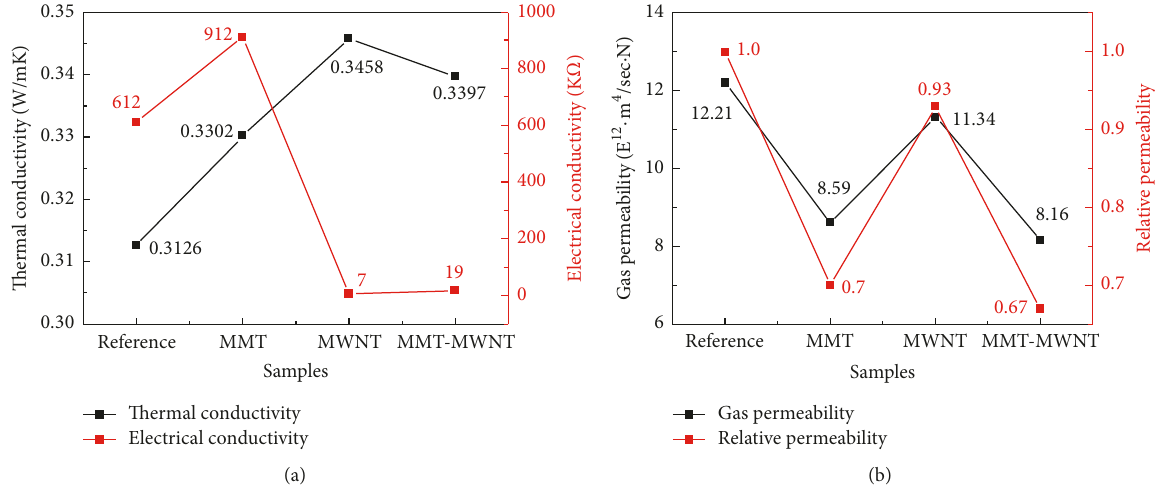
Figure 5: Thermal, electrical, and gas permeability properties of elastomer nanocomposites . (a) Thermal and electrical conductivities of the elastomer nanocomposites with diverse fillers. (b) Gas permeability and relative permeability of the elastomer composites with diverse fillers at 5 phr